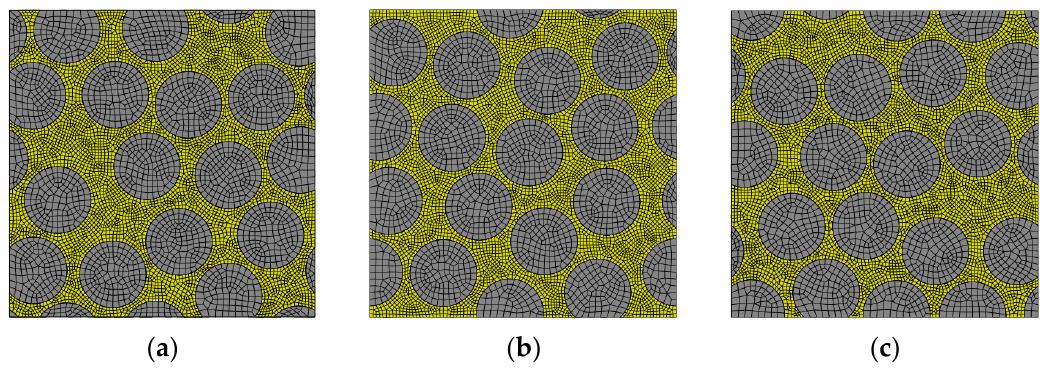
Figure 3. Randomly generated RVE geometries used for the micro-residual stress analysis. ( a ) RVE1, ( b ) RVE2 and ( c ) RVE3.